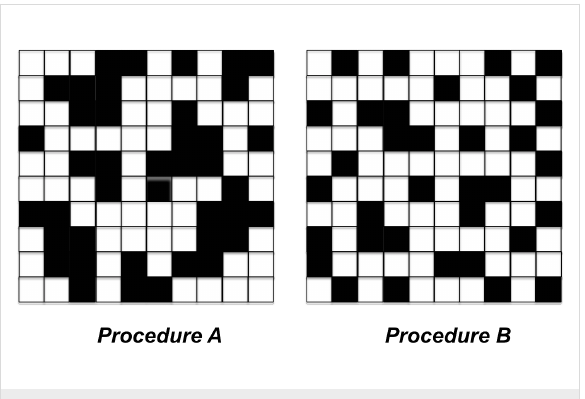
Figure 8: Checkboard model for AgNCs arrays on SiO 2 obtained with procedure A (surface density = 41 NC/ μ m 2 ) and procedure B (surface density = 35 NC/ μ m 2